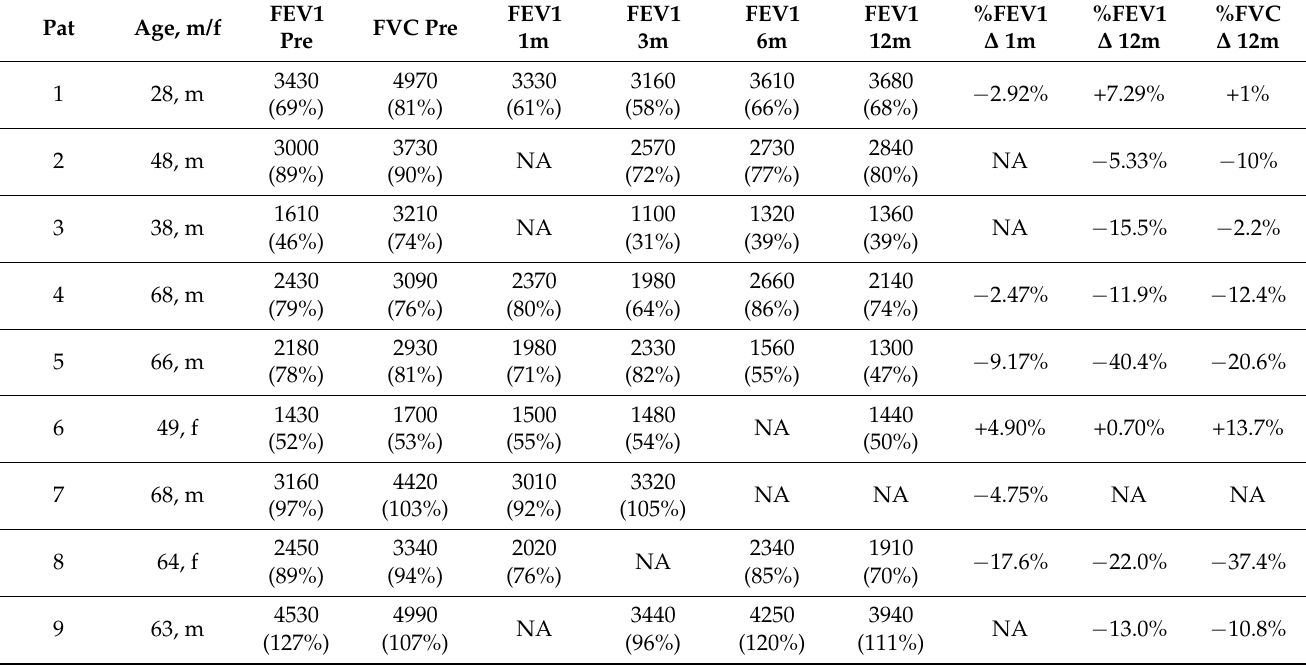
Table 2. Non-vaccinated lung transplant recipients with moderate